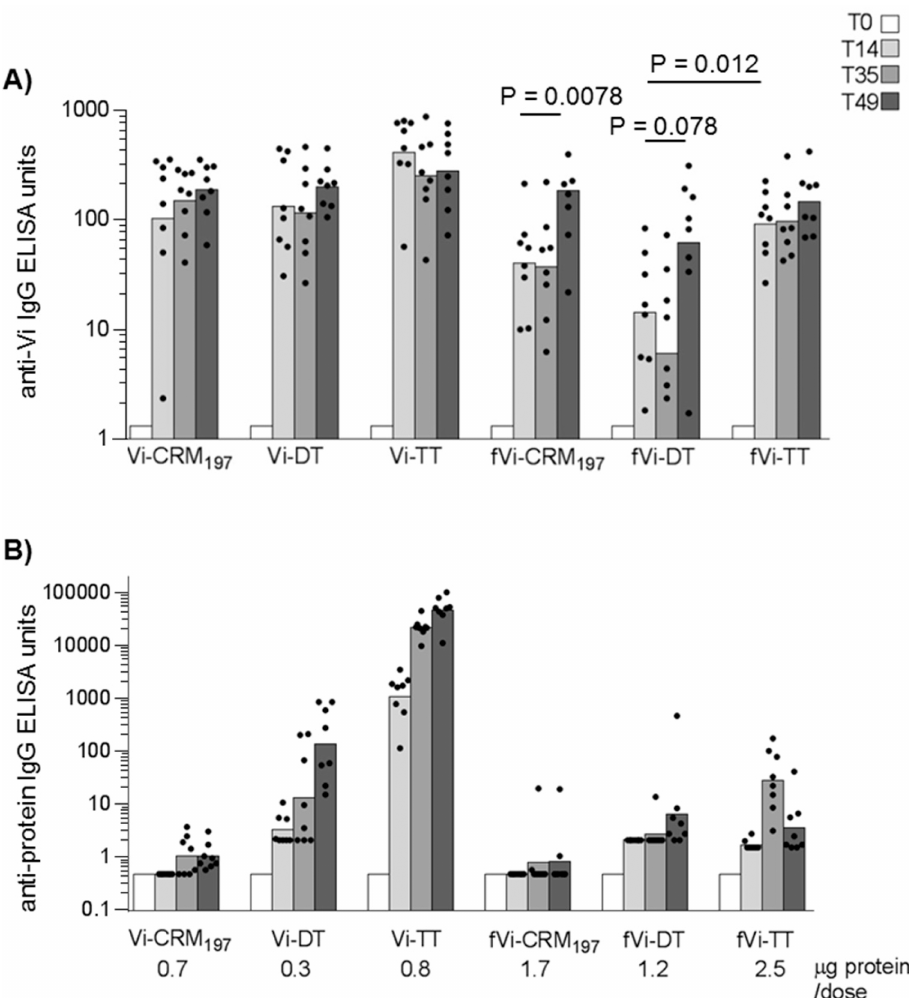
Fig 2. Influence of carrierprotein on the immunogenicity of Vi conjugates in mice. Ten weeks old CD1 mice were immunized at days 0 and 35 with 1 μ g Vi/dose. A) anti-Vi IgG ELISA titres and B) anti-carrierIgG ELISA titres. Bars represent the geometric mean ELISA units of the group in log scale, individual animals are represented by the scatter plots.